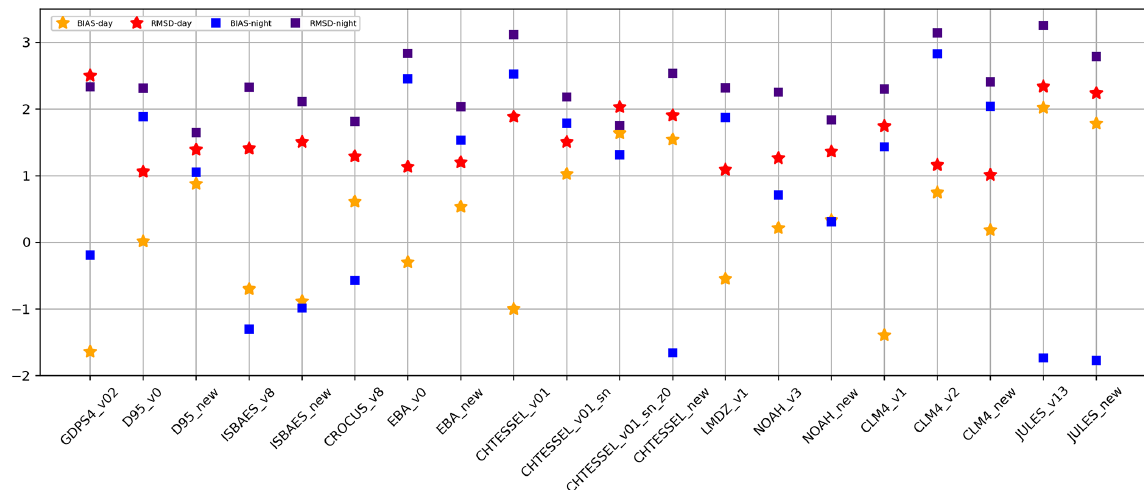
Figure 7. Statistical scores (BIAS and RMSD) during the day and night for the simulations performed for each model configuration. Table 6. Impact of rerun on BIAS and RMSD of model surface temperatures. Bias (K) RMSD (K) RMSD (K) Day Night Day Night XP1 – XP0 Center Model XP0 XP1 XP0 XP1 XP0 XP1 Day Night